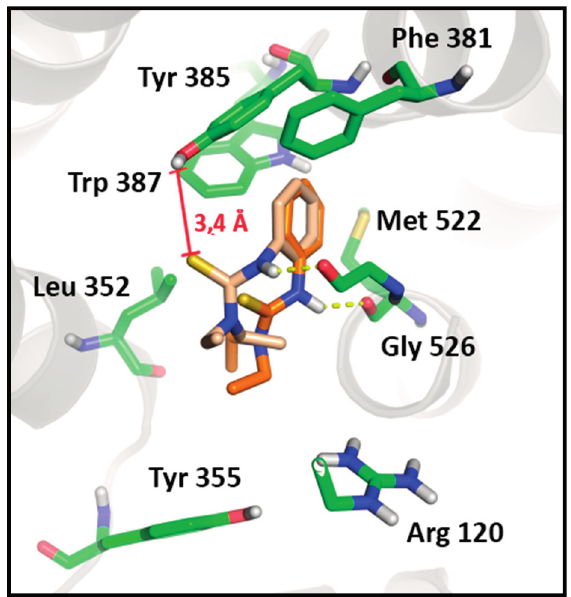
Figure 6. Comparison of the different stable poses observed for the antiplatelet N,N' -disubstituted thiourea derivative ( 3d ) on COX-1. The most stable pose of the first cluster (Orange, Binding Energy = − 3.79) in comparison to the most stable pose of the second cluster (Pink, Binding Energy = − 3.52). Hydrogen bounds are shown as yellow